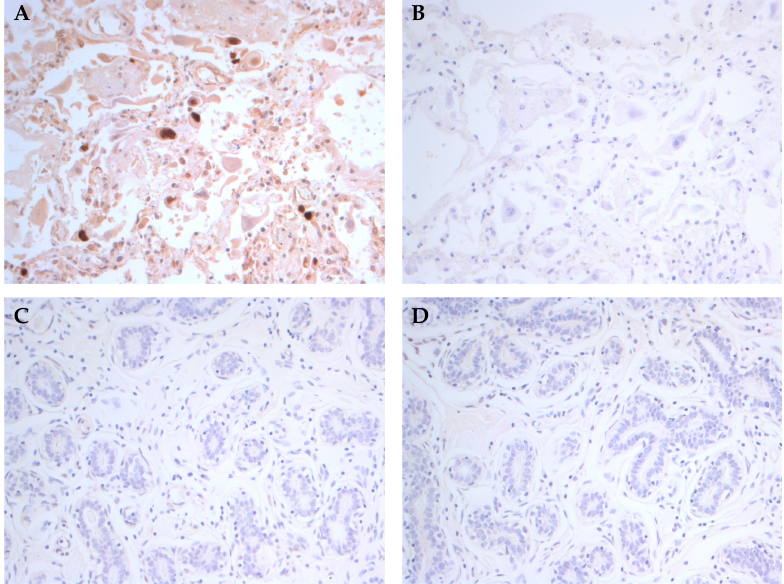
Figure 1. Expression of HCMV-IE protein in HCMV infected lung tissue and normal non-infected breast tissue sections by automated IHC. HCMV-IE protein (brown color) was detected in HCMV infected lung tissue section ( A ) but not in uninfected normal breast tissues ( C ) by the use of an automated IHC approach. Primary antibody was omitted in both tissues sections and served as internal negative controls for IHC method ( B , D ). Original magnification ×20.